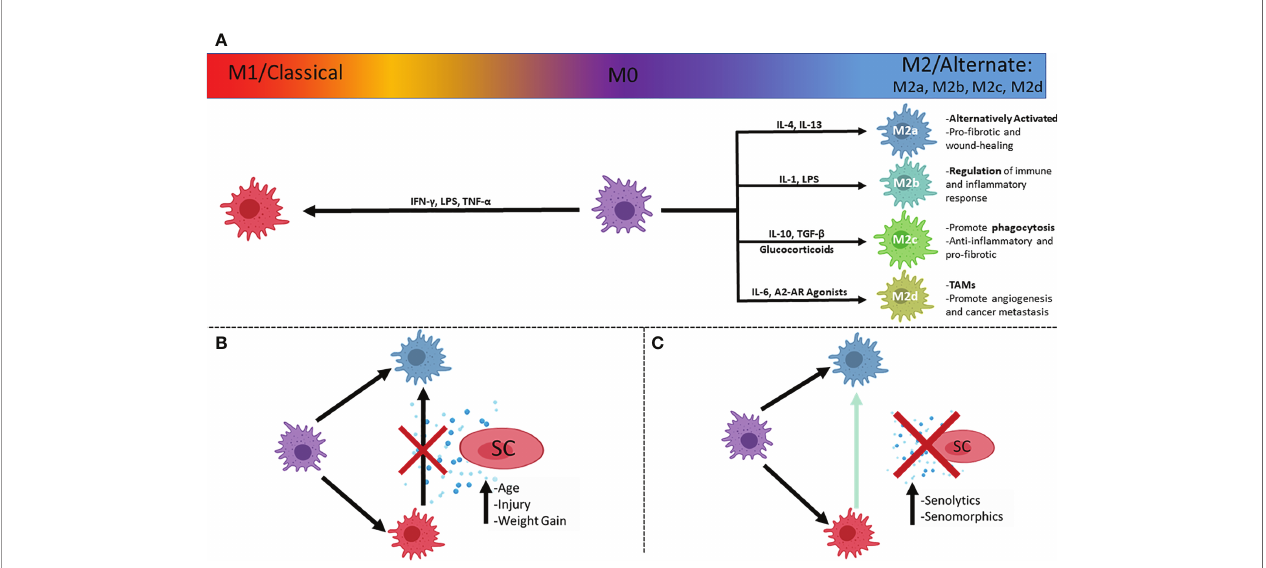
FIGURE 2 | The simpli fi ed polarizations of macrophages and potential interactions with senescent cells. (A) Macrophages can be in an unpolarized M0 state, and polarize to the classical in fl ammatory M1 state, or the alternately activated, pro-reparative M2 state, with subcategories of M2 activation that dictates function, with prominent drivers listed. (B) Plasticity of macrophages allows a shift in polarized states from M1 to M2 that can be inhibited by the secretosome of senescent cells (SASP), associated with injuries to organs and increasing age. (C) Inhibition of polarization shift can be ameliorated with pharmaceutical compounds ultimately minimizing the effect of the SASP. SC, Senescent cell; TAMs, Tumor Associated